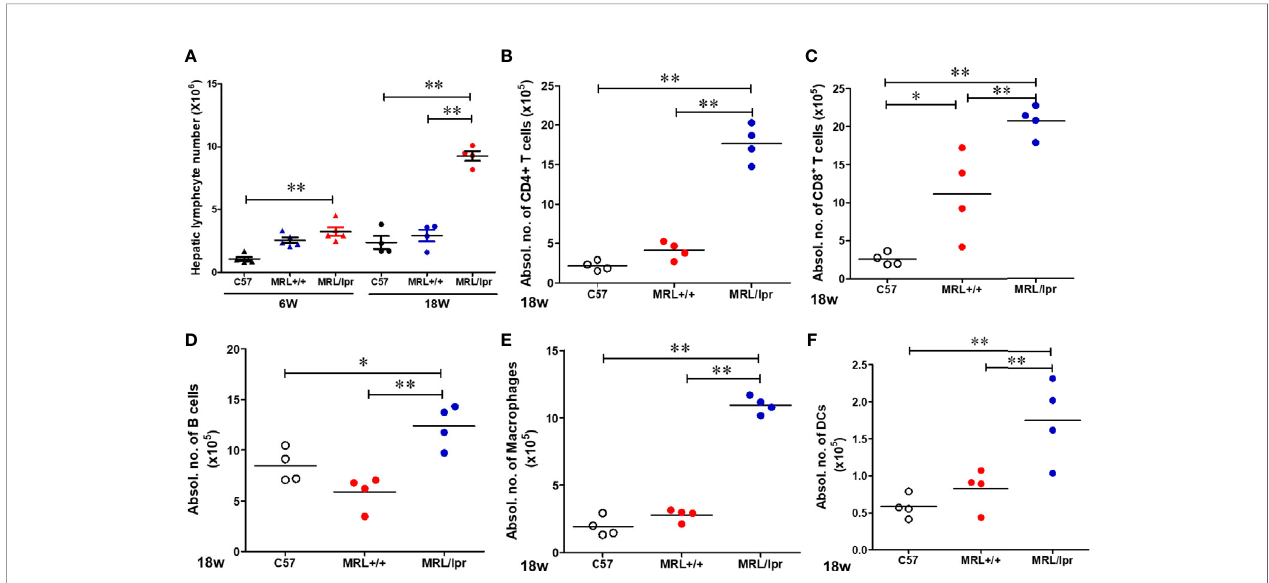
FIGURE 2 | Flow cytometric analysis of hepatic immune cell populations in C57BL/6, MRL+/+ and MRL/lpr mice. (A) Hepatic lymphocytes numbers in 6-week and 18-week old mice. (B – F) Absolute numbers of CD4+ T cells (CD3+ CD4+ CD8 − ), CD8+ T cells (CD3+ CD4 − CD8+), B cells (CD3 − B220+), macrophages (CD11b+ F4/80+) and DCs (CD11B+CD11c+) in the livers of 18-week-old mice. Each symbol represents an individual mouse, and horizontal lines indicate the mean. n = 4 * p < 0.05; ** p <